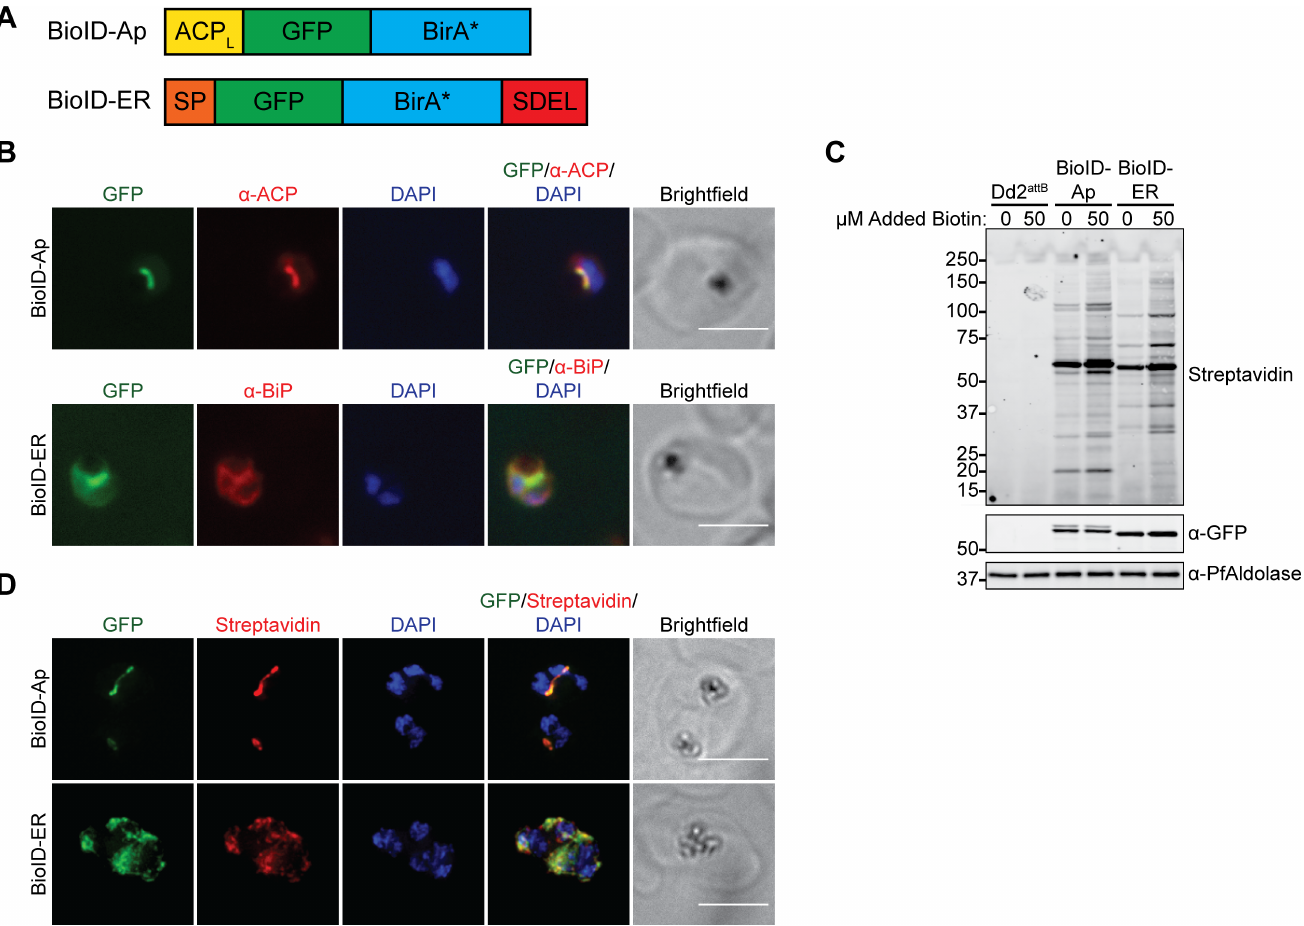
Fig 1. The promiscuous biotin ligase BirA (cid:3) biotinylates proteins in the P . falciparum apicoplast and ER. (A) Schematic (not to scale) of constructs for apicoplast- and ER-targeting of GFP–BirA (cid:3) . (B) Fixed-cell imaging of BioID–Ap and BioID–ER parasites stained with antibodies raised against the apicoplast marker ACP or the ER marker BiP, respectively. Scale bars, 5 μ m. (C) Western blot of untreated and biotin-labeled Dd2 attB , BioID–Ap, and BioID–ER parasites. (D) Fixed-cell imaging of biotinylated proteins in biotin-labeled BioID–Ap and BioID–ER parasites. Scale bars, 5 μ m. ACP, acyl carrier protein; ACP L , ACP leader sequence; BirA (cid:3) , promiscuous E . coli biotin ligase; BioID, proximity-dependent biotin identification; BiP, binding immunoglobulin protein; ER, endoplasmic reticulum; GFP, green fluorescent protein; SDEL, ER-retention motif; SP, signal peptide.